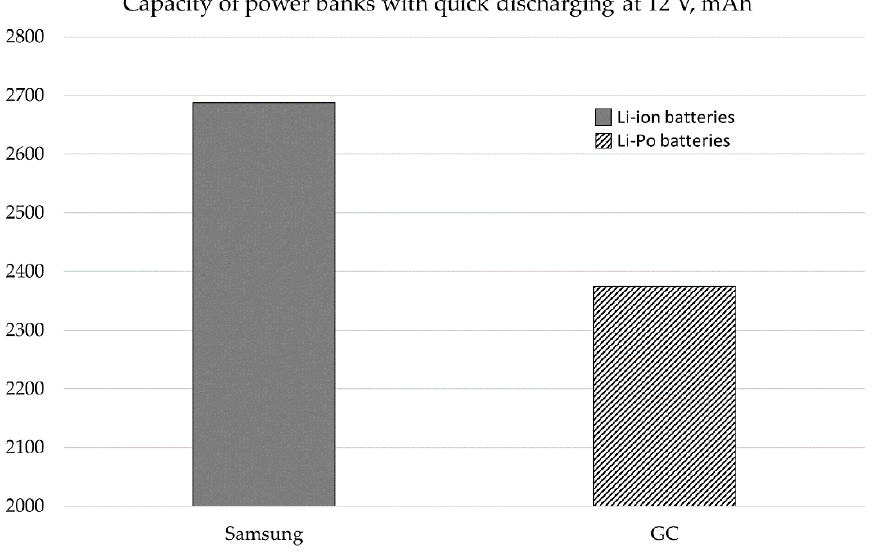
Figure 10. Capacity in mAh of power banks with quick discharging at a voltage U = 12 V. Taking into account the charging time and the usable capacity of the power banks tested under the same conditions at a voltage U = 5 V, a parameter was defined showing the average capacity of a power bank recovered during the charging process in each minute. This parameter, i.e., the ratio of capacity (mAh) to charging time (min), is presented in Table 5. Table 5. Comparison of capacity, charging time, and the calculated parameter showing the effectiveness of charging the power bank over time.